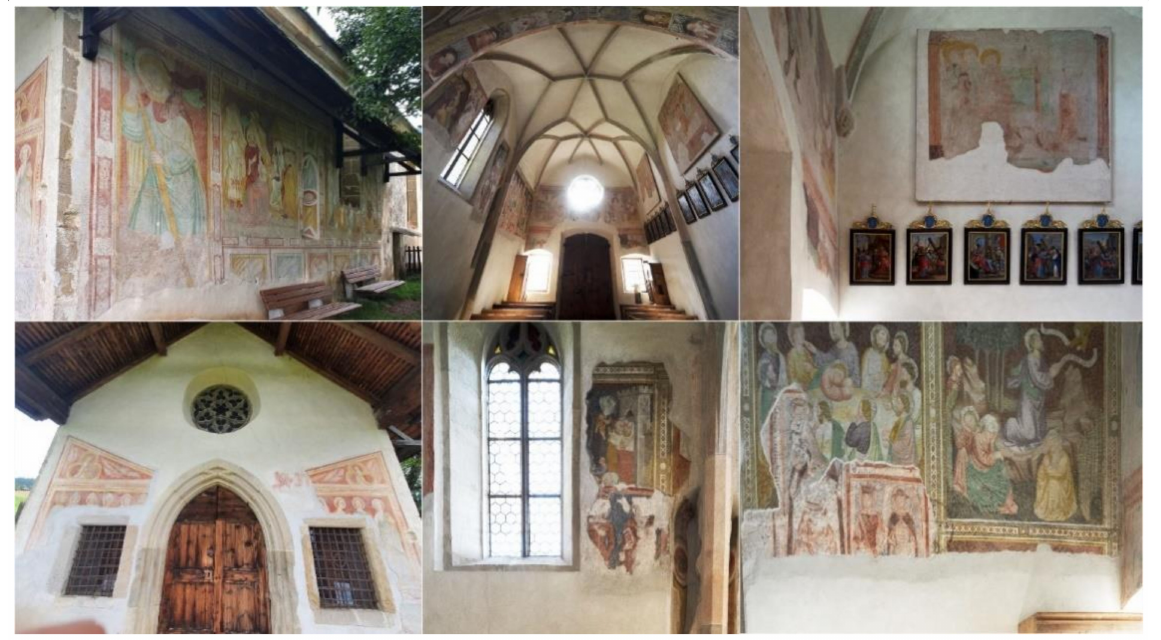
Figure 4. Frescoes and paintings of the Church. Source: F. Dalpiaz.